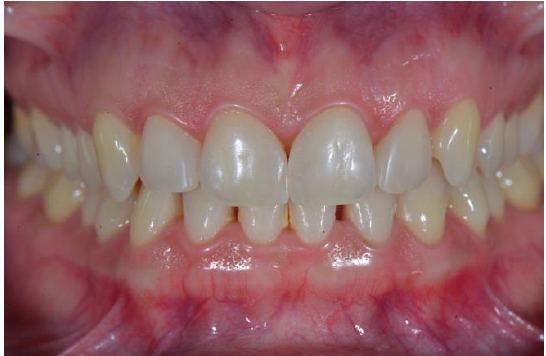
Figure 13. Post-operative retracted view.